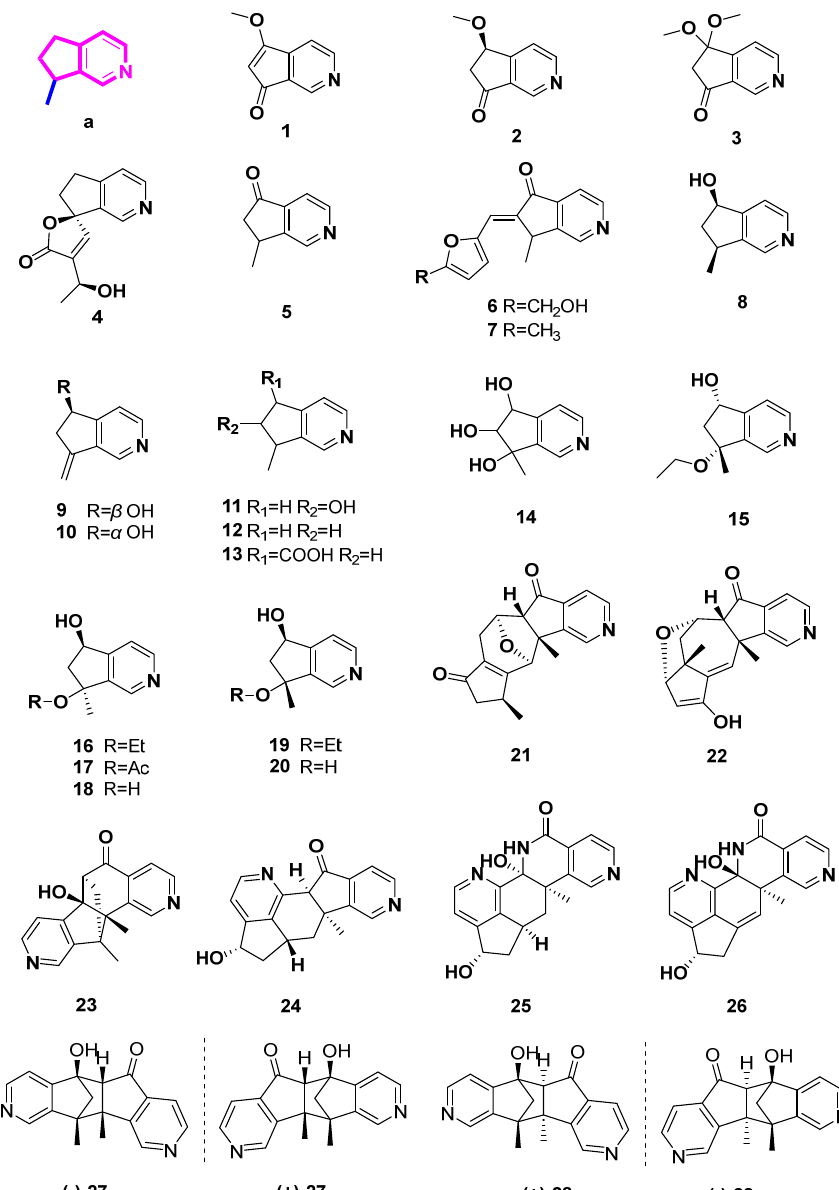
Figure 2. Structures of pyridine alkaloids derived from 4-demethyliridoids (Type